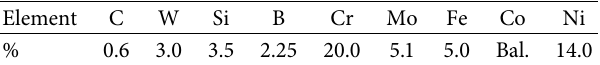
Table 2: Chemical composition of Co powder using in the ex- periment